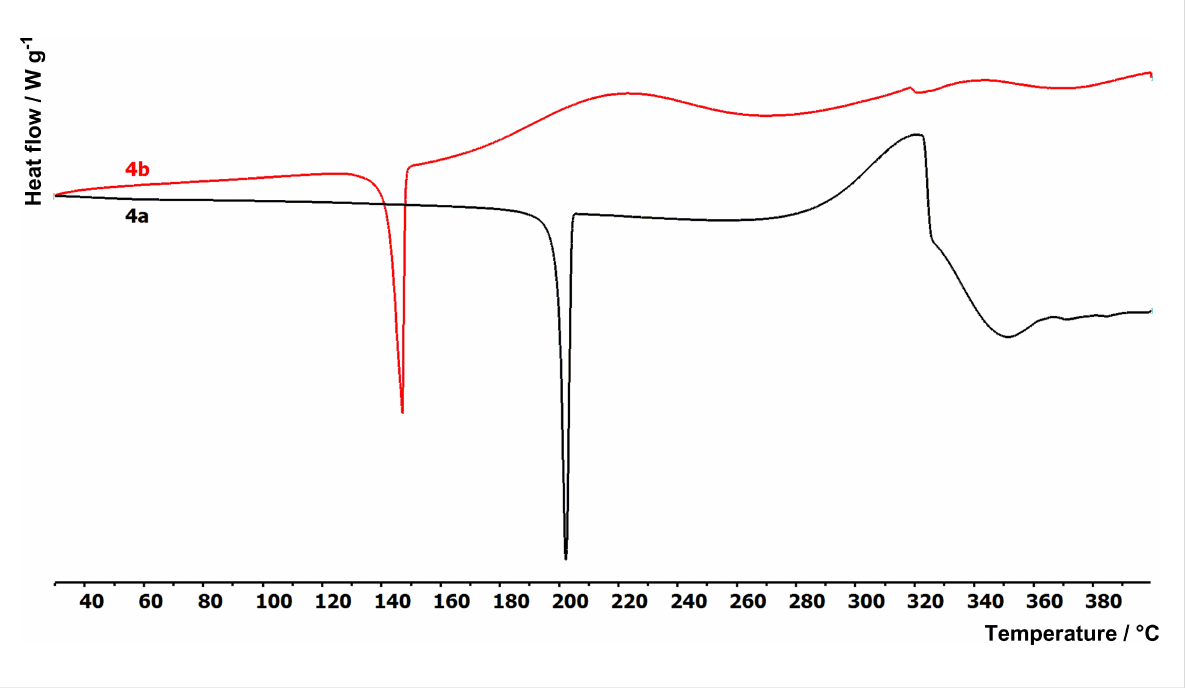
Figure 2: Thermograms of representative chromophores 4a and 4b